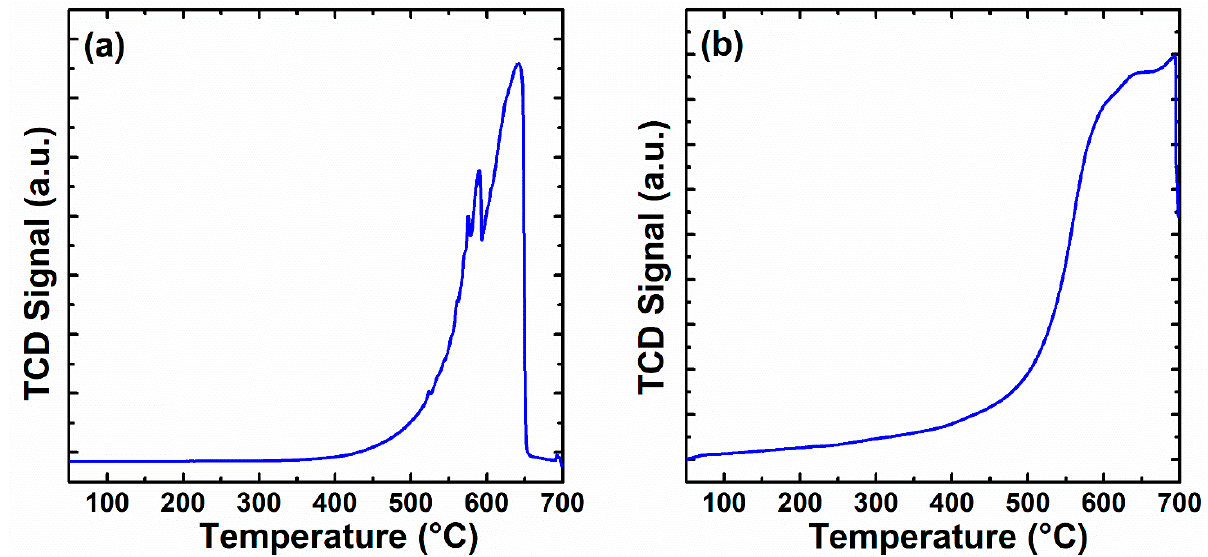
Figure 5. H 2 -TPR profile ( a ) and O 2 -TPO ( b ) of the catalyst. Table 4. H 2 -TPR profiles and O 2 -TPO peaks data.